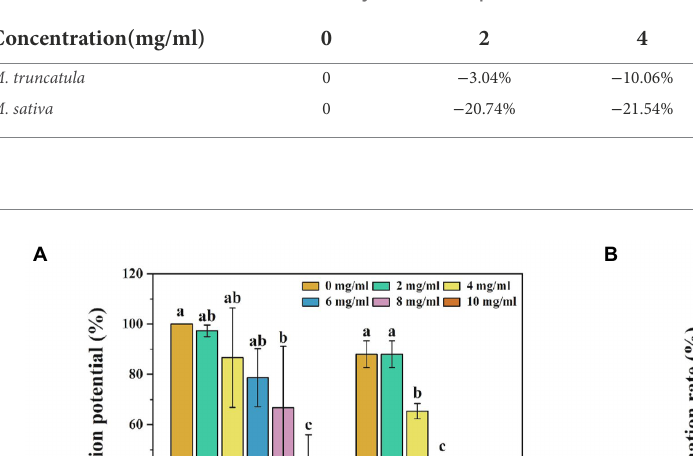
TABLE 1 Effects of M. truncatula extracts on synthetic allelopathic effect index (SE).